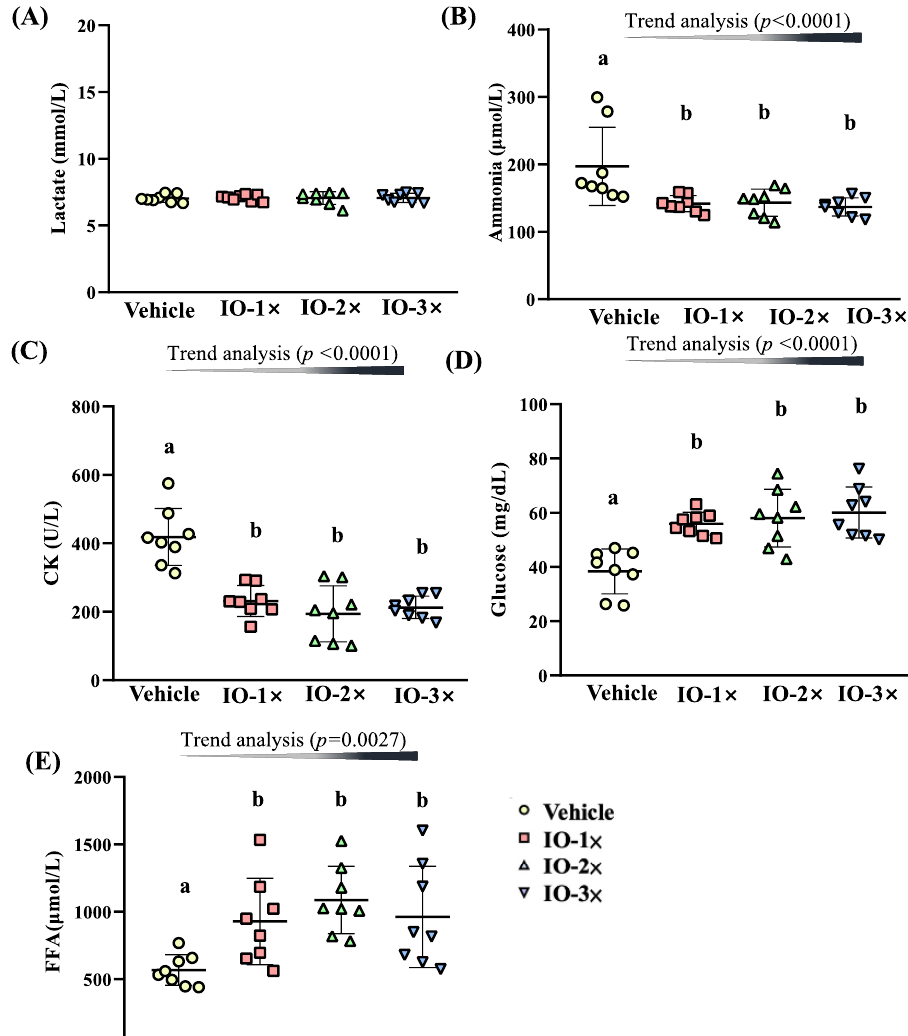
Figure 4. Effect of IO supplementation on the acute exercise biochemical test. Lactate ( A ); ammonia ( B ); creatine kinase ( C ); glucose ( D ); and free fatty acids ( E ). Male ICR mice were pretreated with the vehicle, IO-1 × , IO-2 × , and IO-3 × supplementation and underwent an exercise performance test 1 h after the final administered dose. Different letters (a, b) indicate a significant difference at p < 0.05.